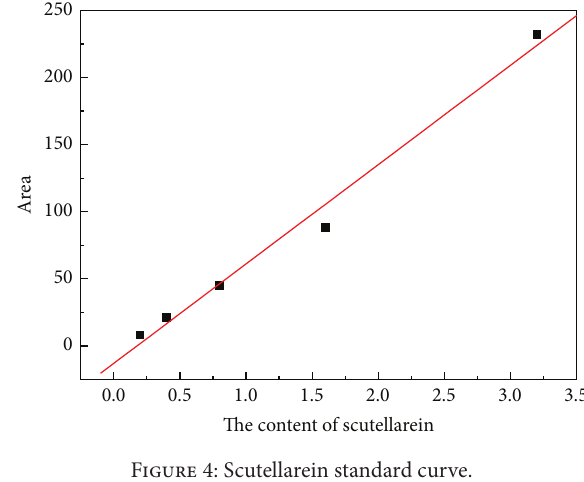
Figure 4: Scutellarein standard curve.